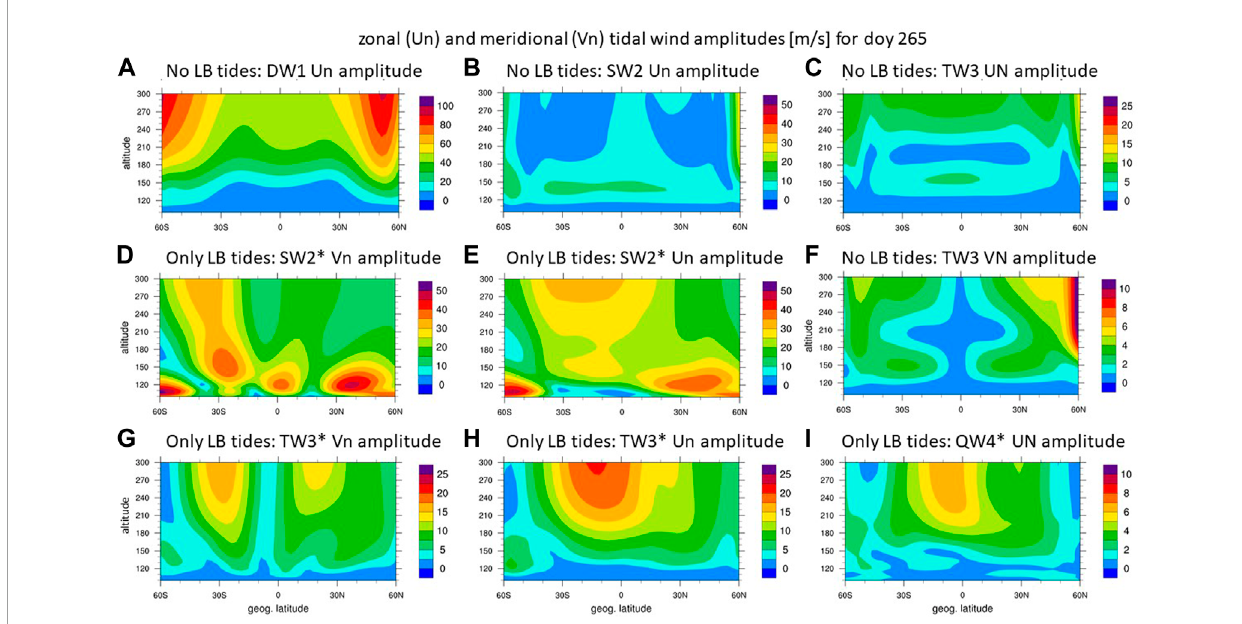
FIGURE 5 Amplitude of migrating solar tides in neutral wind [m/s] at DOY 265 over geographic latitude from the simulation with no LB tides (A) . DW1 in zonal wind, (B) . SW2 in zonal wind, (C) . TW3 in zonal wind, (F) . TW3 in meridional wind; and only due to tides at the LB (D) . SW2 in meridional wind, (E) . SW2 in zonal wind, (G) . TW3 in meridional wind, (H) . TW3 in zonal wind, (I) . QW4 in zonal